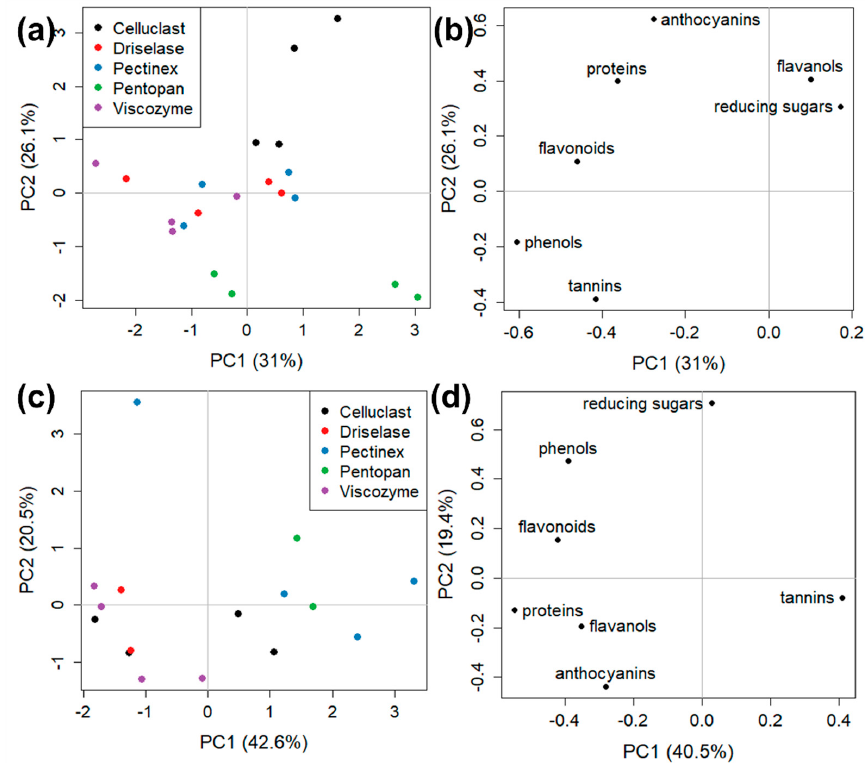
Figure 6. PCA models for ( a , b ) enzymatic and ( c , d ) acetone Garganega extracts. Score colors are based on the different enzymes used for the extraction treatment. ( a , c ) score plots and ( b , d ) loading